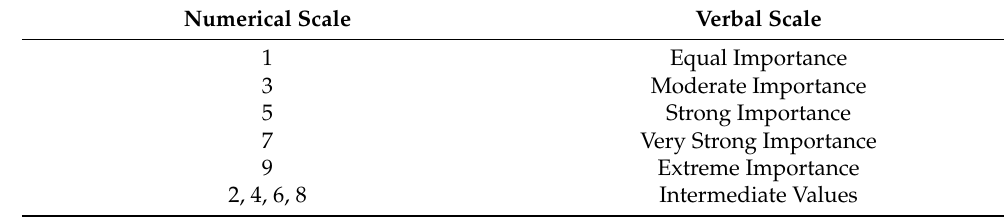
Table 1. Saaty’s fundamental